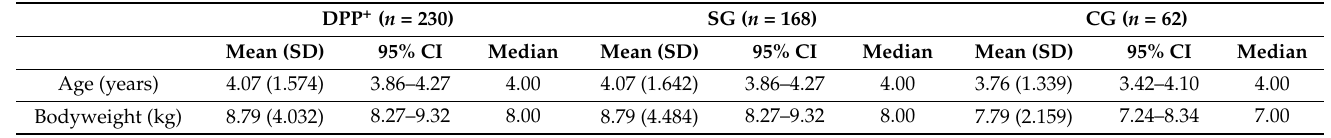
Table 1. DPP + population characterizations at admission ( n =